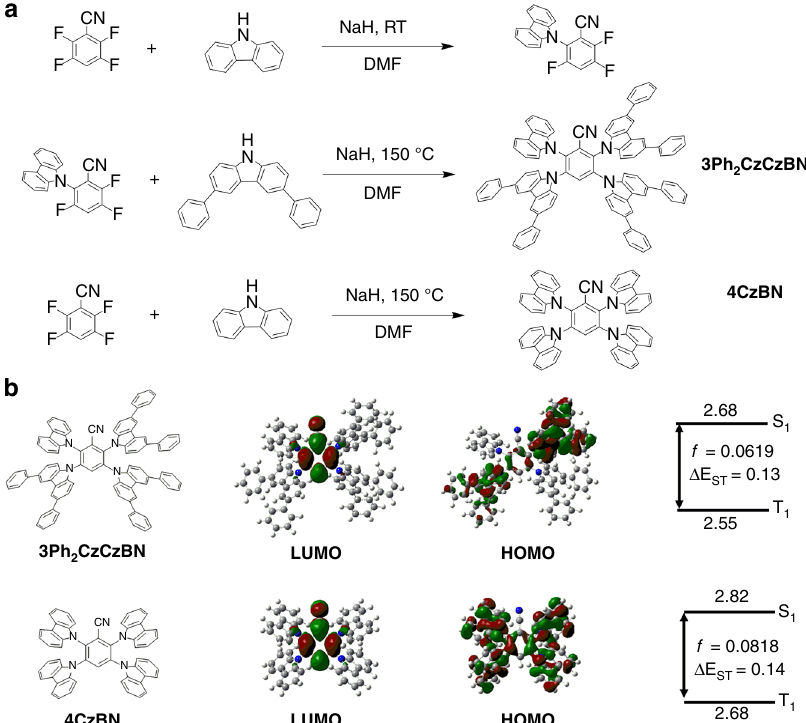
Fig. 1 Synthetic scheme and quantum chemical calculations of the blue emitters. a Synthetic scheme of 3Ph 2 CzCzBN and 4CzBN . b Quantum chemical calculations of 3Ph 2 CzCzBN and 4CzBN Table 1 Photophysical and thermal properties of 3Ph 2 CzCzBN and 4CzBN